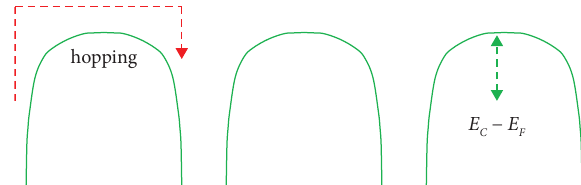
Figure 4: In red, the PF picture of electron hopping between traps originating from potential humps created by the Coulomb inter- action between trapping centers. Te barrier height E C − E F is the potential diference between the conduction band and Fermi